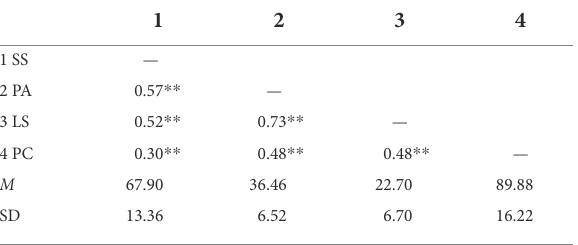
TABLE 1 Descriptive statistics and correlation coefficients of the key study variables ( n =